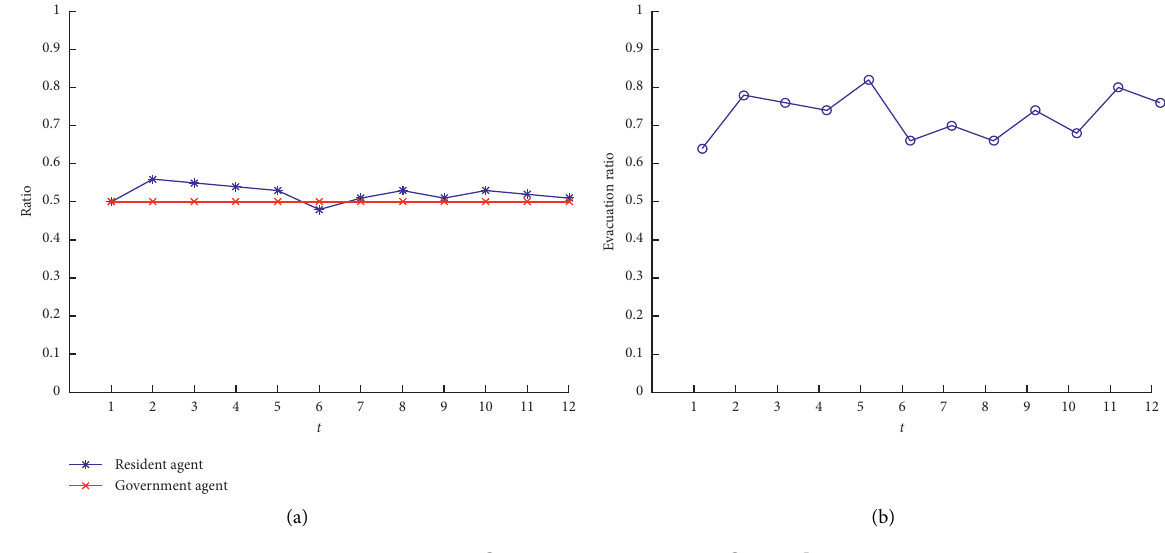
Figure 8: Evolution with fixed P G � 0 . 5. (a) Evolution of P G and P R . (b) Entire